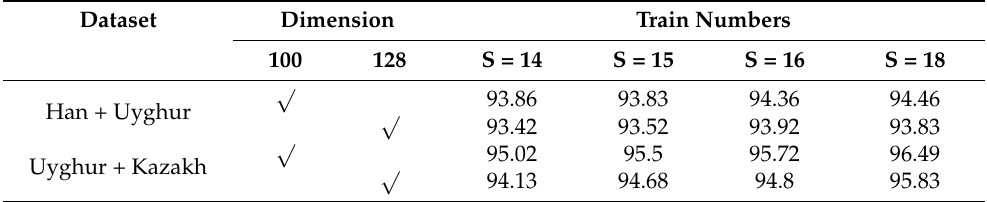
Table 4. Multilingual Mixed Signature Recognition Results Based on HOG